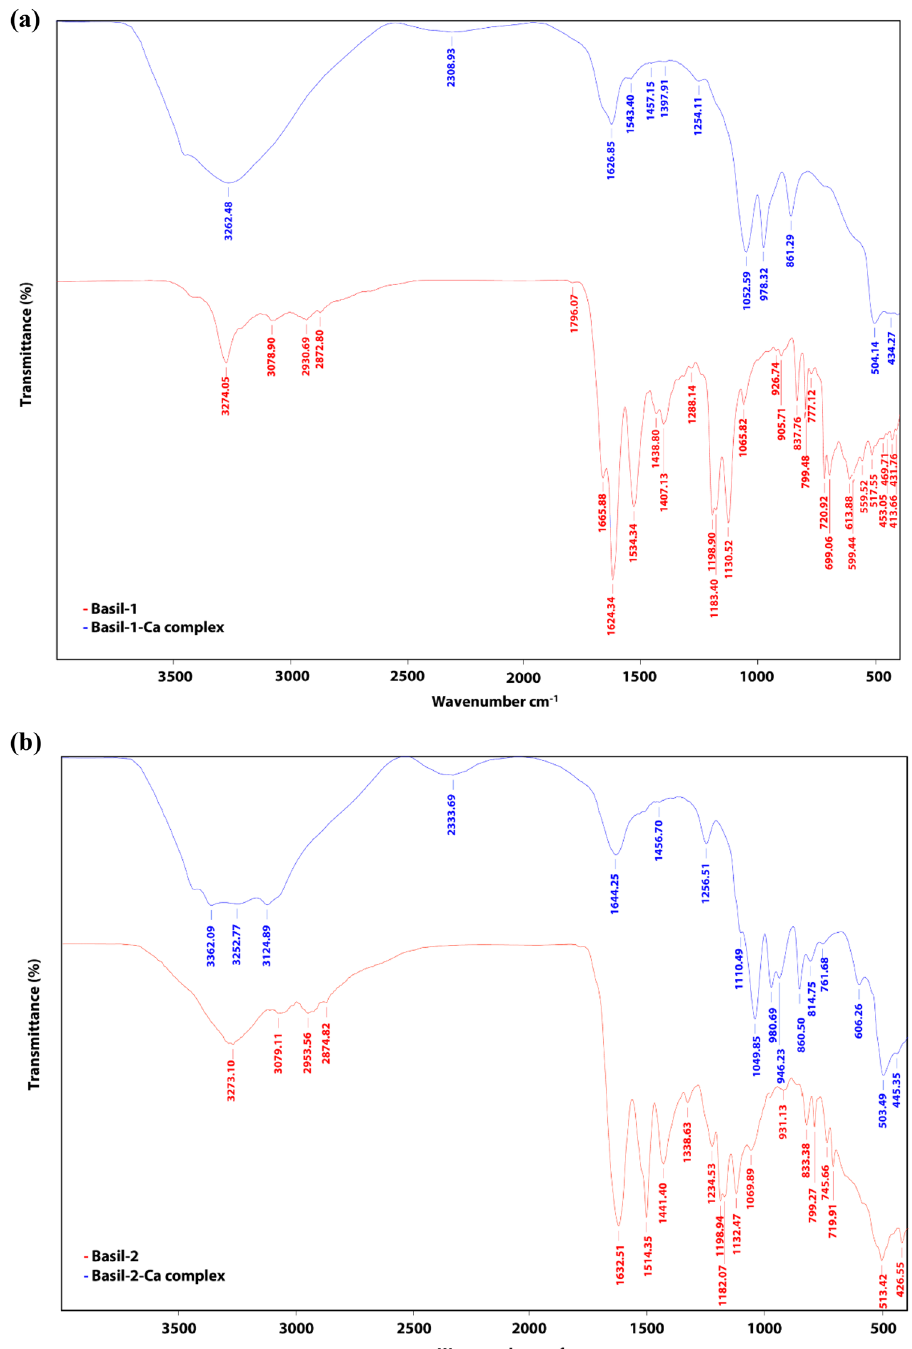
Figure 4. The FTIR spectra of: ( a ) Basil-1 and the Basil-1-calcium complex; ( b ) Basil-2 and the Basil-2-calcium